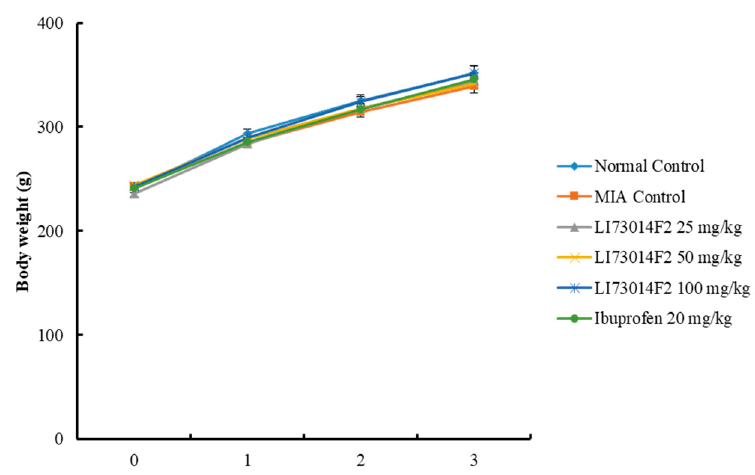
Figure 1. Effects of LI73014F2 on changes in body weight in monosodium iodoacetate (MIA)-induced osteoarthritis in rats. Body weight was evaluated once a week for 3 weeks and data are presented as mean ± SEM ( n = 8/group). No significant difference was detected between all the groups.